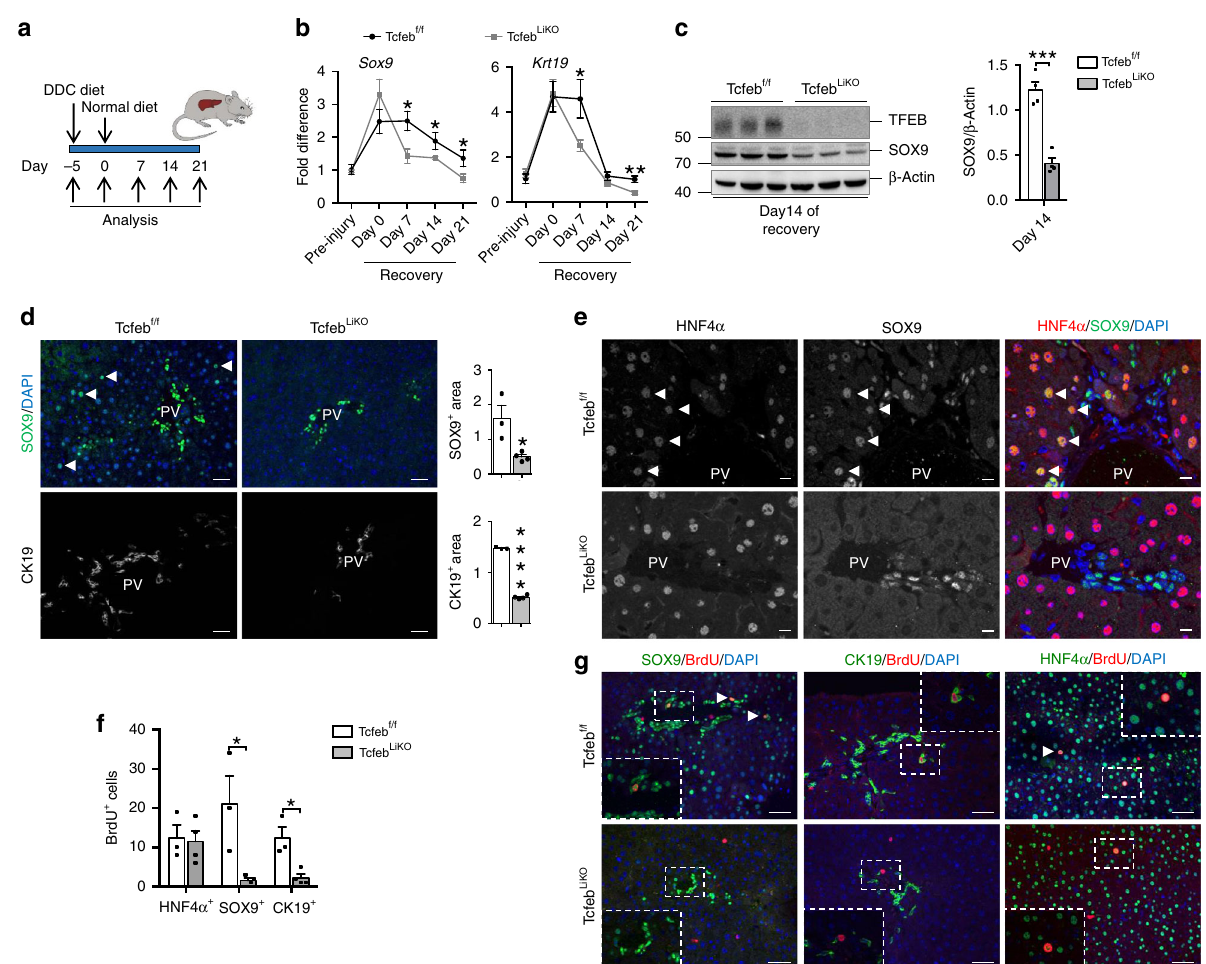
Fig. 5 TFEB depletion impairs ductular reaction and cell proliferation after liver injury. a Experimental strategy for liver injury protocol for TFEB LiKO mice. b , c Expression levels of Sox9 and Krt19 mRNA (pre-injury n = 3, day 0 – 7 – 14 – 21 n = 5 biological replicates per genotype) at different time points ( b ) and immunoblotting with relative quanti fi cation ( n = 4 biological replicates) ( c ) of livers isolated from TFEB f/f and TFEB LiKO mice 14 days after discontinuation of DDC food. In b , values are expressed as fold difference relative to TFEB f/f mice. Data are represented as mean ± SEM. * p ≤ 0.05, ** p ≤ 0.01, *** p ≤ 0.001 two-tailed Student ’ s t -test. d SOX9 and CK19 immuno fl uorescence with relative quanti fi cations (TFEB f/f n = 3, TFEB LiKO n = 4 biological replicates/ n = 5 different images/sample) of liver isolated from TFEB f/f and TFEB LiKO mice 14 days after recovery and relative quanti fi cations. Scale bar 50 μ m. e HNF4 α / SOX9 dual staining of liver sections from TFEB f/f and TFEB LiKO mice. Scale bar 5 μ m. f , g Quanti fi cation of BrdU + cells ( n = 3 biological replicates/ n = 5 different images/sample) ( f ) and representative images ( g ). Scale bar 50 μ m. Data are represented as mean ± SEM. * p ≤ 0.05 two-tailed Student ’ s t